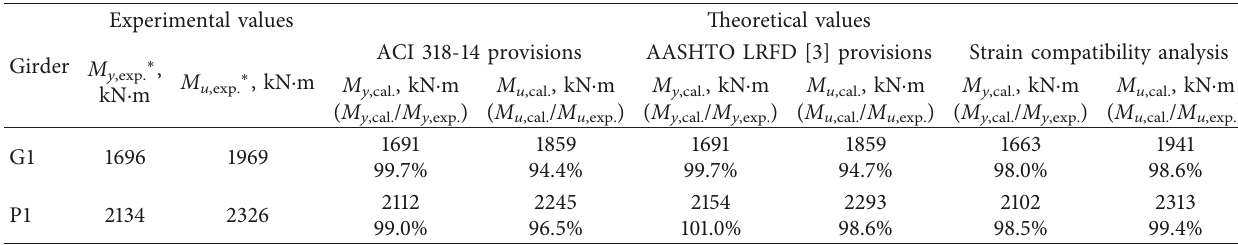
Table 4: Yielding and ultimate moment values for girders G1 and P1.